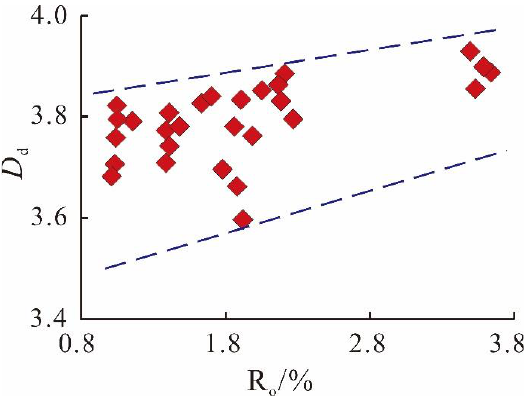
p ) and vitrinite reflectance (R o ).